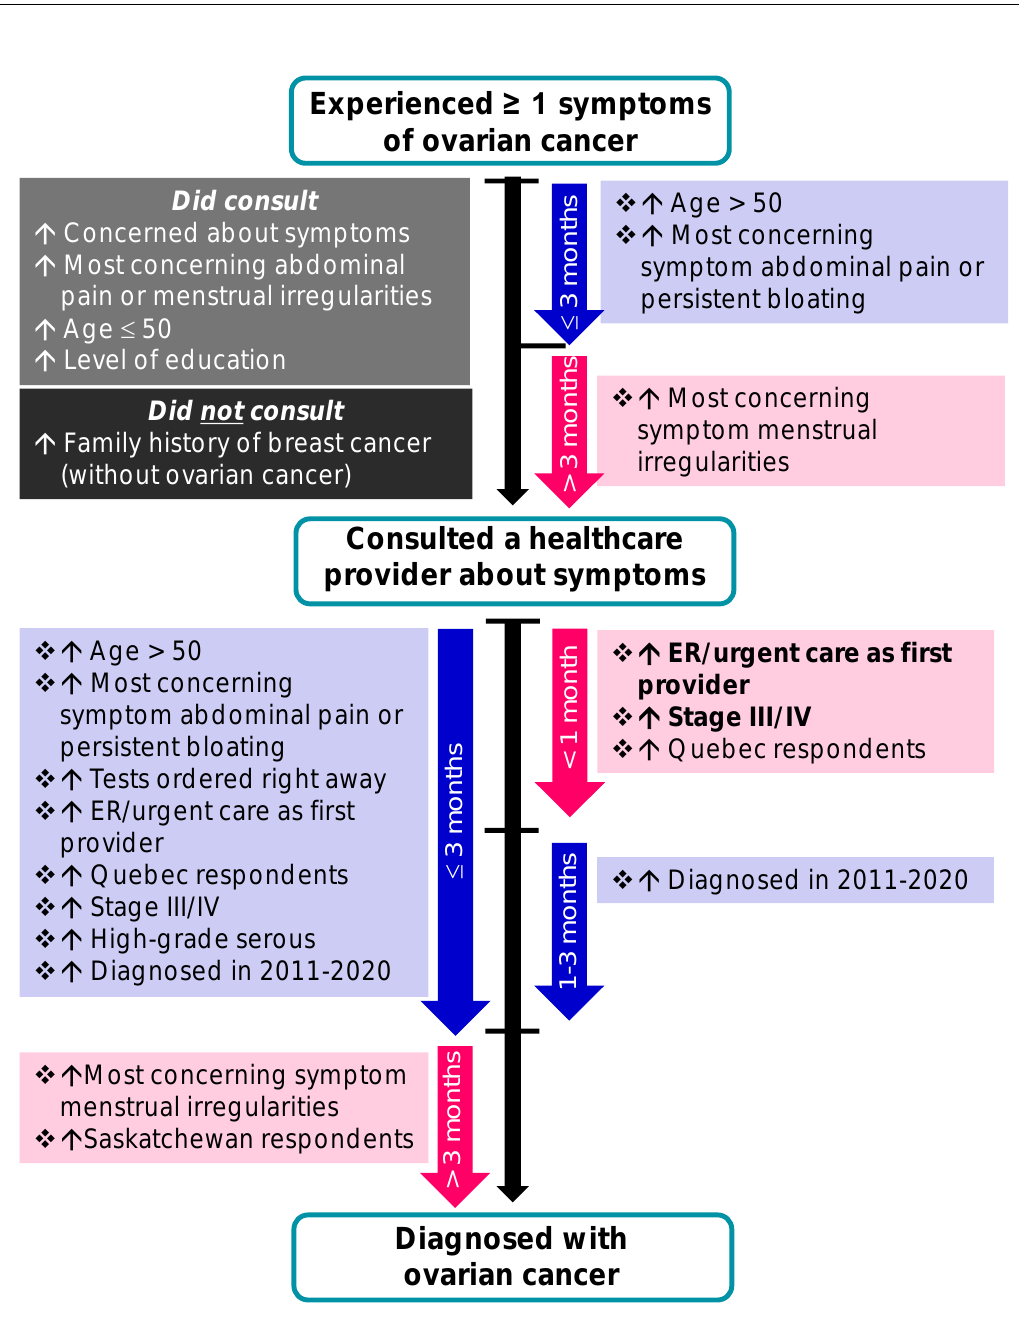
Figure 2. Predictors along the diagnostic pathway. Variables predicting the time between experiencing symptoms and visit with a healthcare provider (time to consult) and between the first visit and diagnosis of ovarian cancer (time to diagnosis) is shown. Women in Quebec, those who had advanced disease and those who initiated ER consultation had a shorter time to diagnosis.